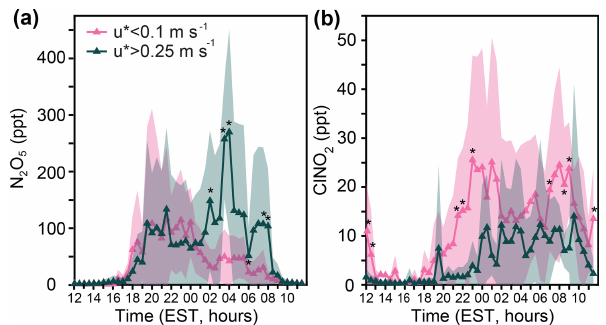
Figure 4. Campaign-wide diel patterns of 30min averaged (a) N 2 O 5 and (b) ClNO 2 , binned by lower ( u ∗ < 0 . 1ms − 1 ) and higher ( u ∗ > 0 . 25ms − 1 ) friction velocities. Shading repre- sents 1 standard deviation. Asterisks represent statistically signif- icant ( t test) differences at the p < 0 . 05 level between the lower and higher friction velocity bins for each 30min period from 20 January–24 February (excluding 20–21 February when the sonic anemometer was not operational). The number of 30min time peri- ods, from 18:00–08:00, is reported as n . Lower turbulence occurred 39% of the time ( n = 391), and higher turbulence occurred 14% ( n = 137) of the time. Sonic anemometer data were unavailable for 5% ( n = 53) of nighttime